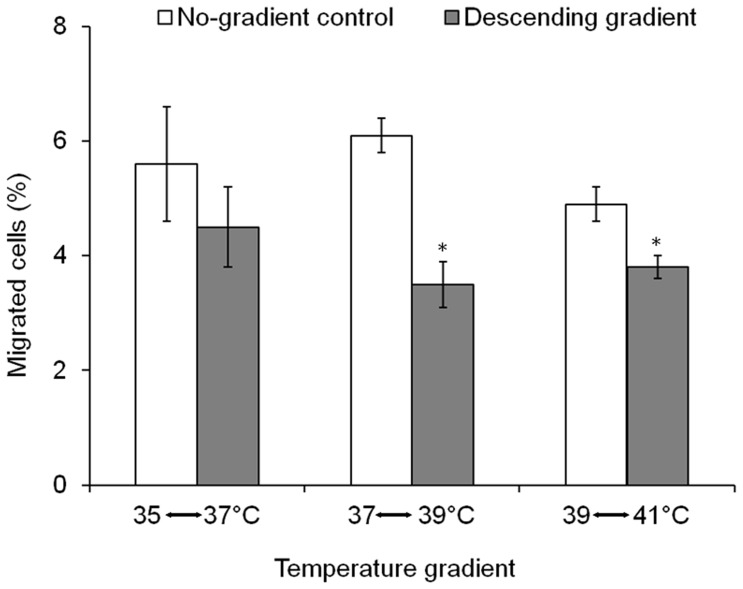
Migration of human spermatozoa in a descending temperature gradient.The temperatures shown in the abscissa were measured by the thermocouples at both ends of the tube (externally to the tube). The results are the mean ± SEM of 6–19 determinations (4 experiments for each temperature gradient tested). Asterisks above the columns indicate a statistically significant difference from the respective no-gradient control (P≤0.01, according to Student’s t-test).